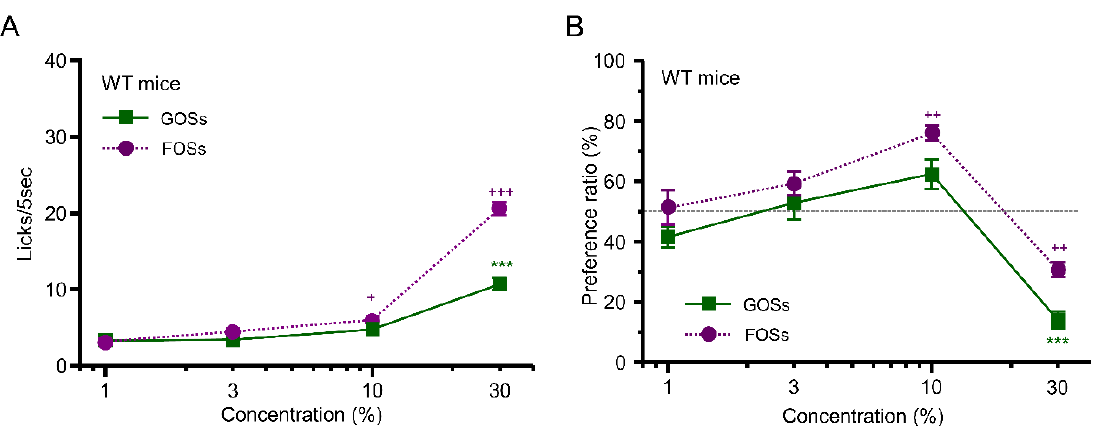
Figure 1. Behavioral responses to sugars in wild-type (WT) mice. ( A ) Number of licks of sucrose (black squares), lactose (red circles), and galactose (blue triangles) in the short-term (5 s) lick test ( n = 7). ( B ) Preference ratio for sucrose (black squares), lactose (red circles), and galactose (blue triangles) in the 48 h two-bottle test ( n = 6). ## p < 0.01, *** p < 0.001, +++ p < 0.001, ### p < 0.001, post hoc Tukey highest-significant-difference (HSD) test (vs. 10 mM). All data are presented as the mean ± standard error.